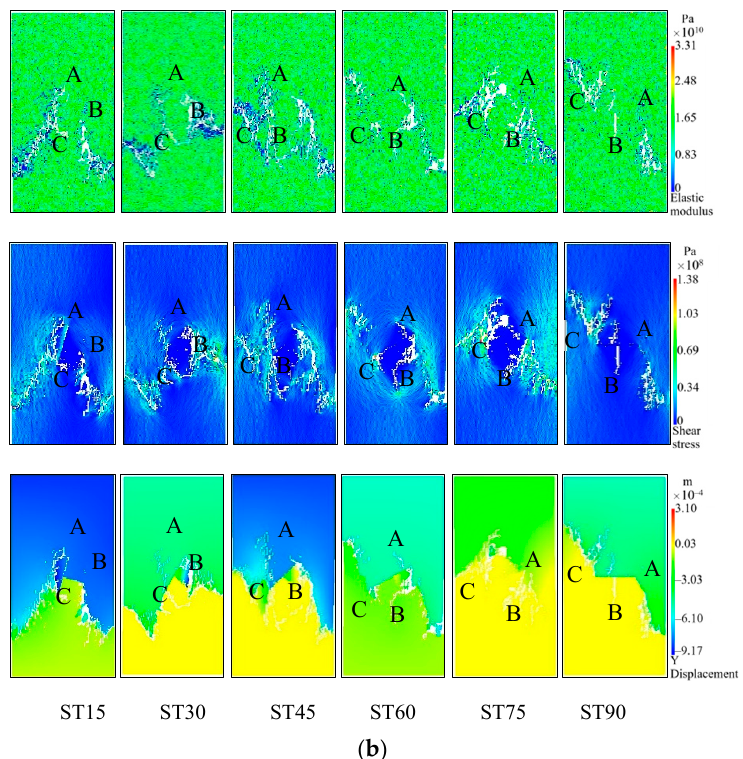
Figure 12. Simulation results of T-shaped fracture sandstone specimens under the action of hydro-mechanical coupling. ( a ) Progressive failure process of ST0 specimen, ( b ) Failure modes of ST15-ST90 specimens.